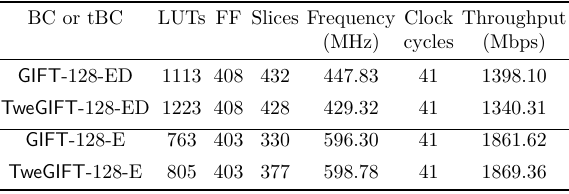
Table 6: Implementation results for GIFT and TweGIFT on Virtex 7 FPGA BC or tBC LUTs FF Slices Frequency Clock Throughput (MHz) cycles (Mbps)